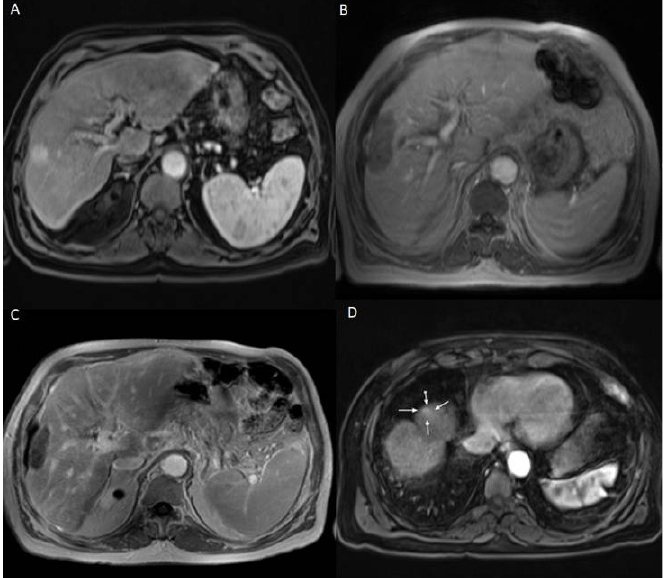
Figure 2. 69 years old male patient with chronic hepatitis C virus, liver cirrhosis, and HCC lesion in the right liver lobe, who was treated with LITT. ( A ) Pre-treatment CEMRI showed an arterial hyperenhancement of the lesion. ( B ) 24 h post-ablation CEMRI showed a large post-ablation zone, and the lesion was fully ablated. ( C , D ) At the 3-months post-ablation CEMRI, the size of the ablation zone was getting decreased without LTP, but there was a hyperenhancement in untreated liver segment (white arrows), which was correlated with IDR. TACE was performed to treat the recurrent HCC and the patient lived for 33 months after LITT until death.